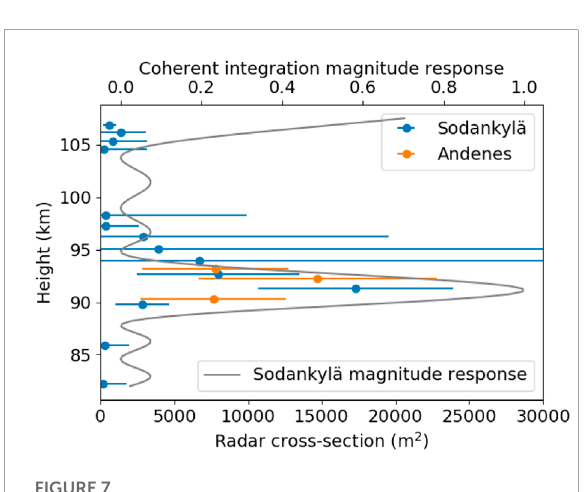
FIGURE 7 Estimates of the radar cross-section as a function of altitude. The normalized magnitude response of the four-pulse coherent integration window of the Sodankylä radar is also included, with Doppler frequency based on the estimated trajectory. The estimates for Sodankylä are corrected for the frequency response of the coherent integration used by the